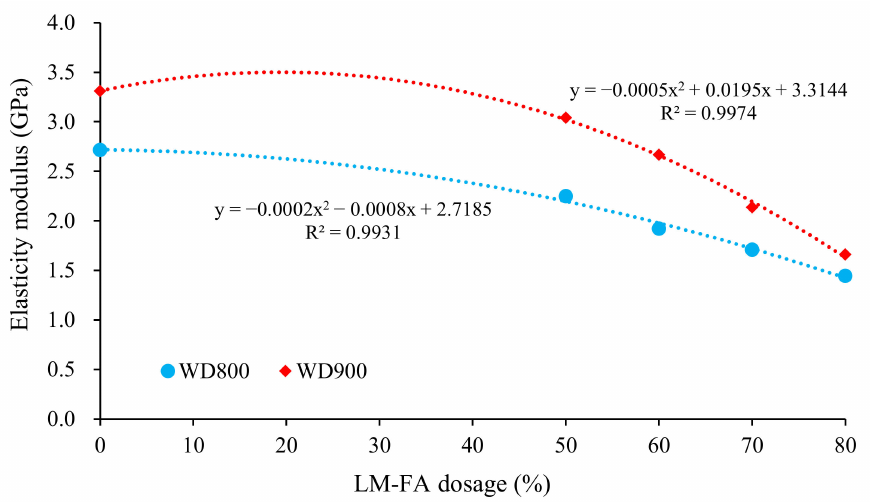
Figure 9. Influence of LM–FA dosage on the elastic modulus of mixtures.